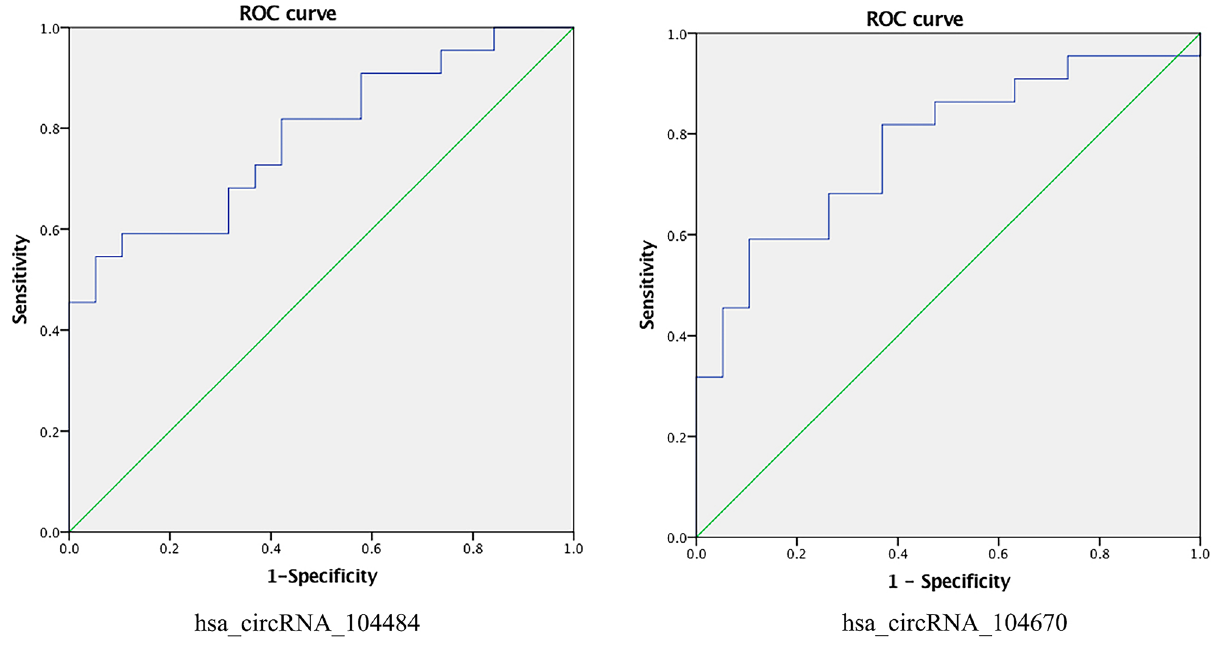
Figure 5. ROC curve for hsa_circRNA_104484 and hsa_circRNA_104670.